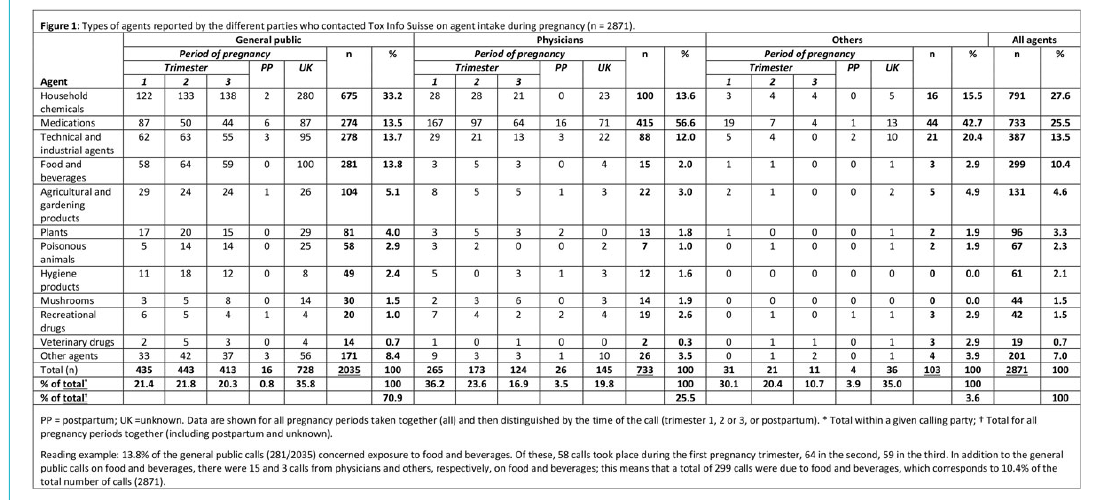
Figure 1: Types of agents reported by the different parties who contacted Tox Info Suisse on agent intake during pregnancy (n =